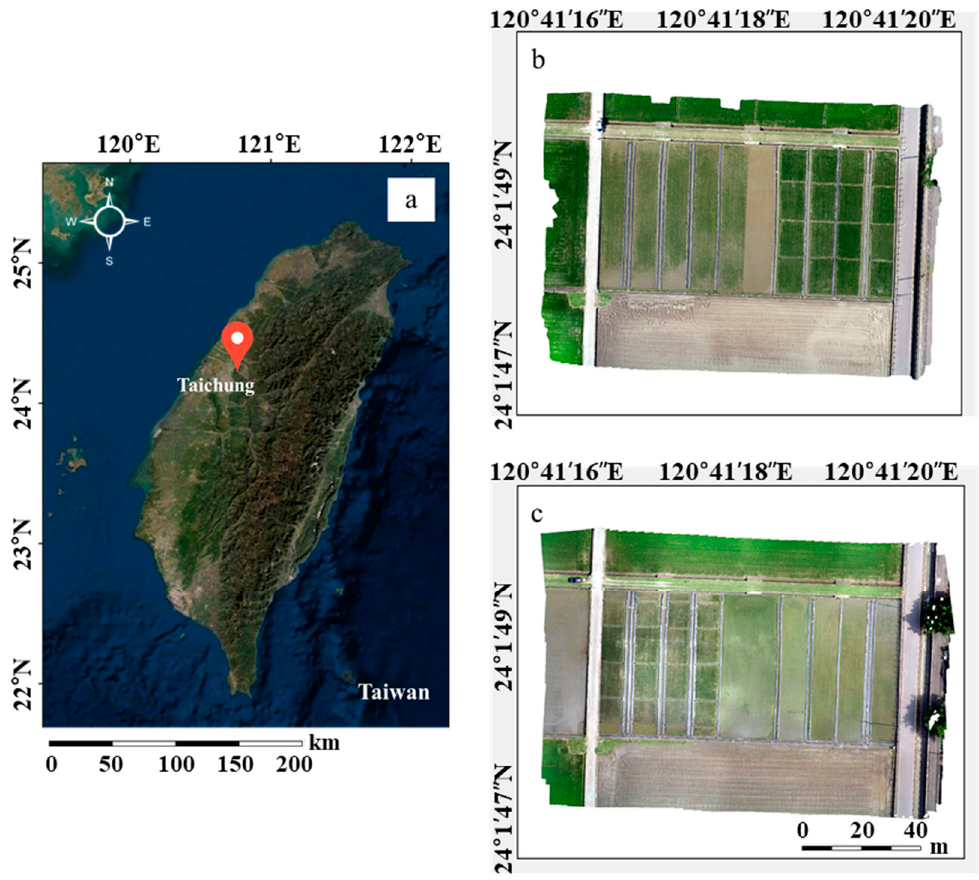
Figure 1. The location of the study area and rice crop in different season. ( a ) Study area located in Taichung, Taiwan. The orthomosaic image produced from the unmanned aerial vehicle (UAV) flight in 2019; ( b ) first crop season; and ( c ) second crop season.